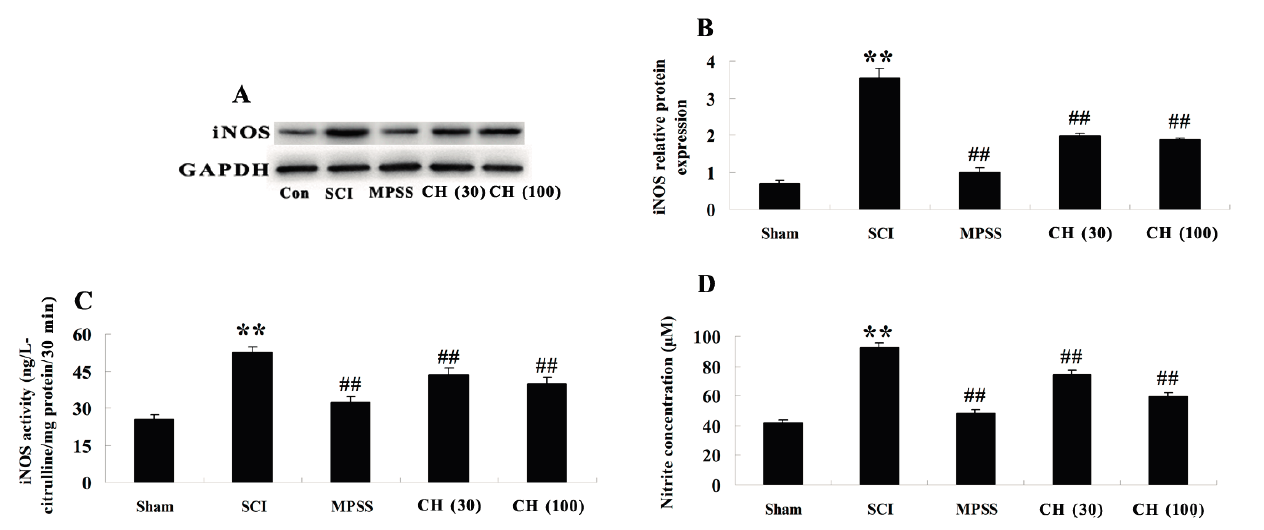
Figure 4. CH decreases the protein level and activity of iNOS (inducible nitric oxide synthase) and the plasma NO (nitric oxide) concentration after SCI. ( A ) The representative images of immunoblots with antibodies against iNOS. iNOS, 130 kDa; GAPDH, 36 kDa; ( B ) The quantitative analysis of the protein level of iNOS in rats’ spinal cords from different groups. The data were normalized to the loading control, GAPDH; ( C ) The measurement of iNOS activity; ( D ) NO production was detected spectrophotometrically by measuring its metabolite, nitrite. ** p < 0.01 compared with the sham group; ## p < 0.01 compared with the SCI group. Sham, sham group; SCI, spinal cord injury group; MPSS, methylprednisolone-treated; CH (30), chrysin (30 mg/kg)-treated; CH (100), chrysin (100 mg/kg)-treated groups.